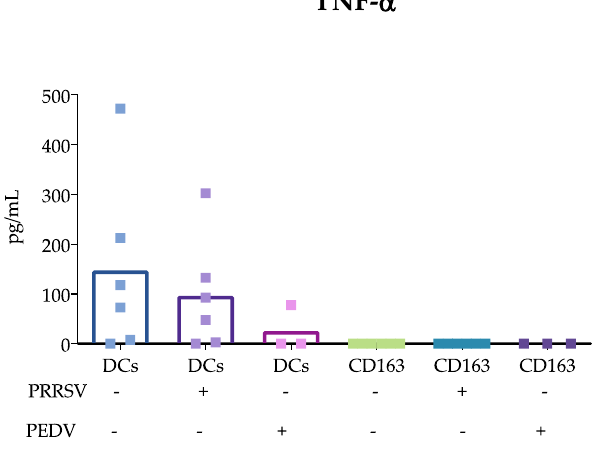
Figure 3. Cytokine production in splenic cDCs and CD163 + cells in response to virus. cDCs and CD163 + cells were stimulated with PEDV or PRRSV for 24 h, and cytokine production was analyzed by ELISA. In each figure, the bars represent the mean and sample size of at least three pigs; each point represents one pig. Data were analyzed with the nonparametric Kruskal-Wallis test, and significant differences between the bars are indicated.